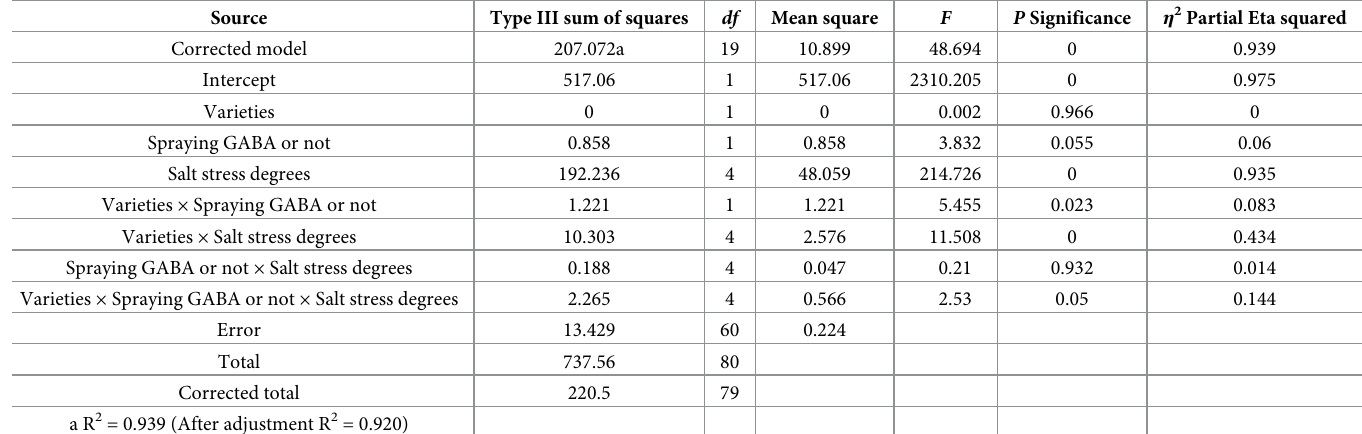
Table 2. Univariate multifactor analysis of variances of the plant height increment of rice seedlings.